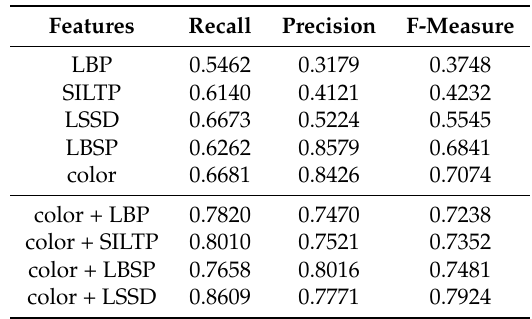
Table 2. Average performance comparison of different features on the CDnet2012 dataset. LBP: Local Binary Pattern; SILTP: Scale-Invariant Local Ternary Pattern; LSSD: Local Similarity Statistical Descriptor; LBSP: Local Binary Similarity Pattern.